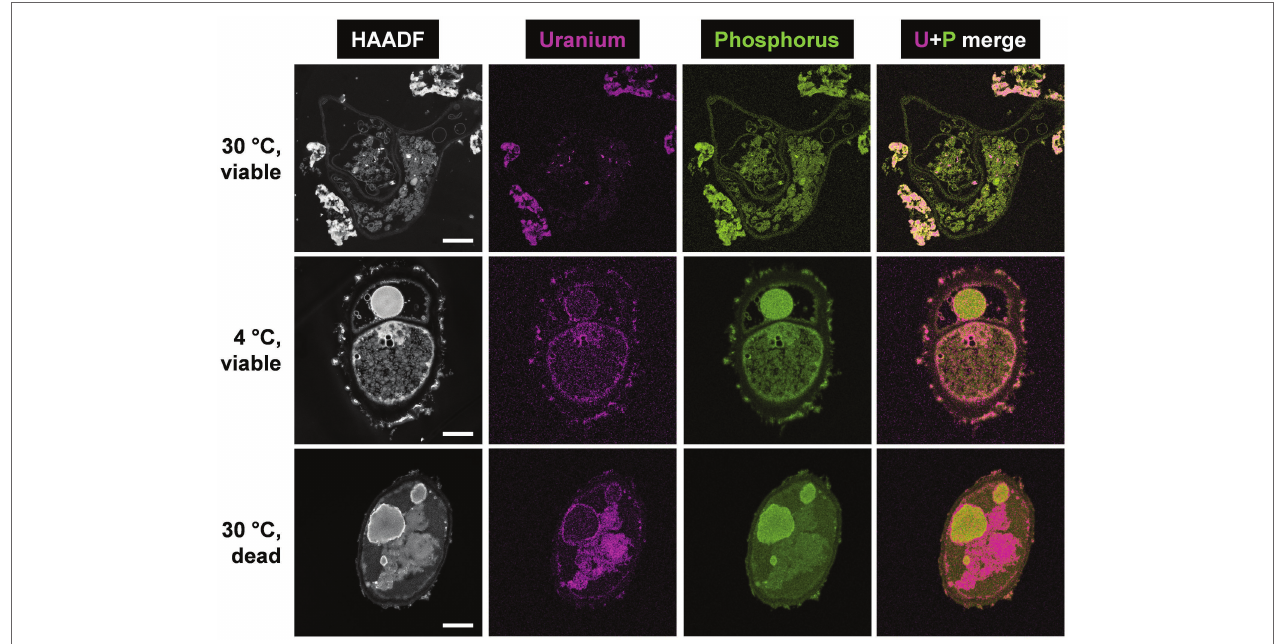
FIGURE 2 | HAADF-STEM micrographs of viable P. simplicissimum KS1 at 30 and 4 ° C (top and center rows) and dead-autoclaved cells at 30 ° C (bottom row) together with EDXS-based element distributions for uranium (magenta) and phosphorus (green). The fungal isolate was incubated in 0.1 mM U (background electrolyte: sterile-filtered tap water pH 5.0) for 48 h. The scale bars indicate 1 μ